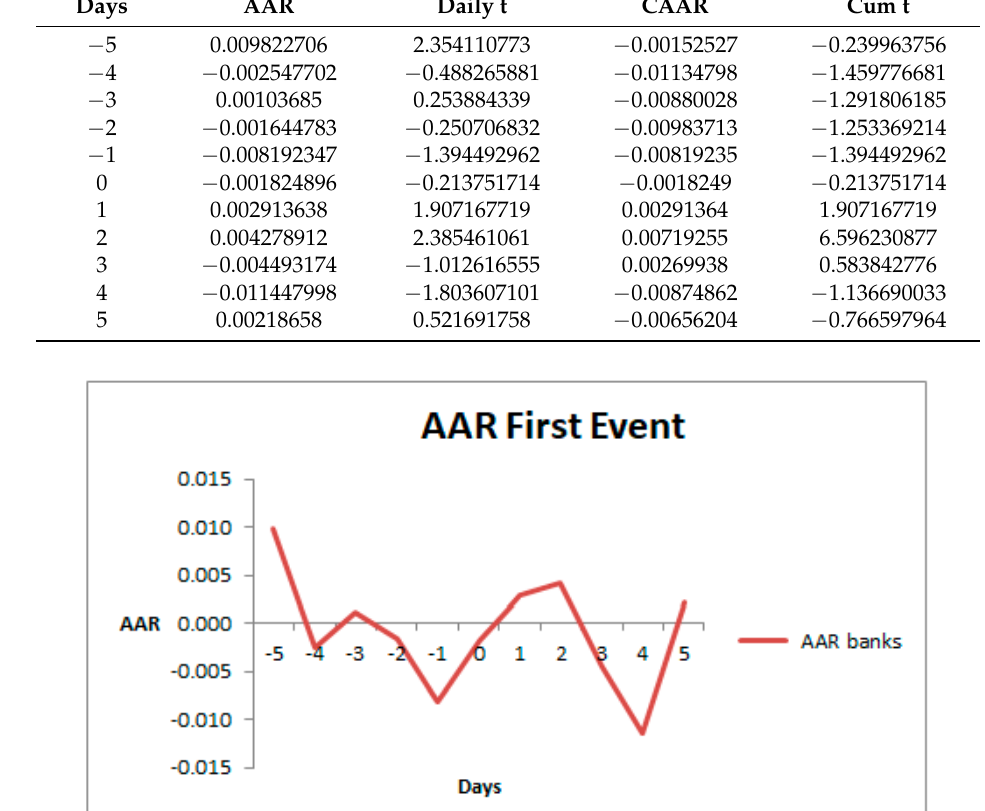
Table 3. Event study results of banks for the second event. Source: Authors’ work.